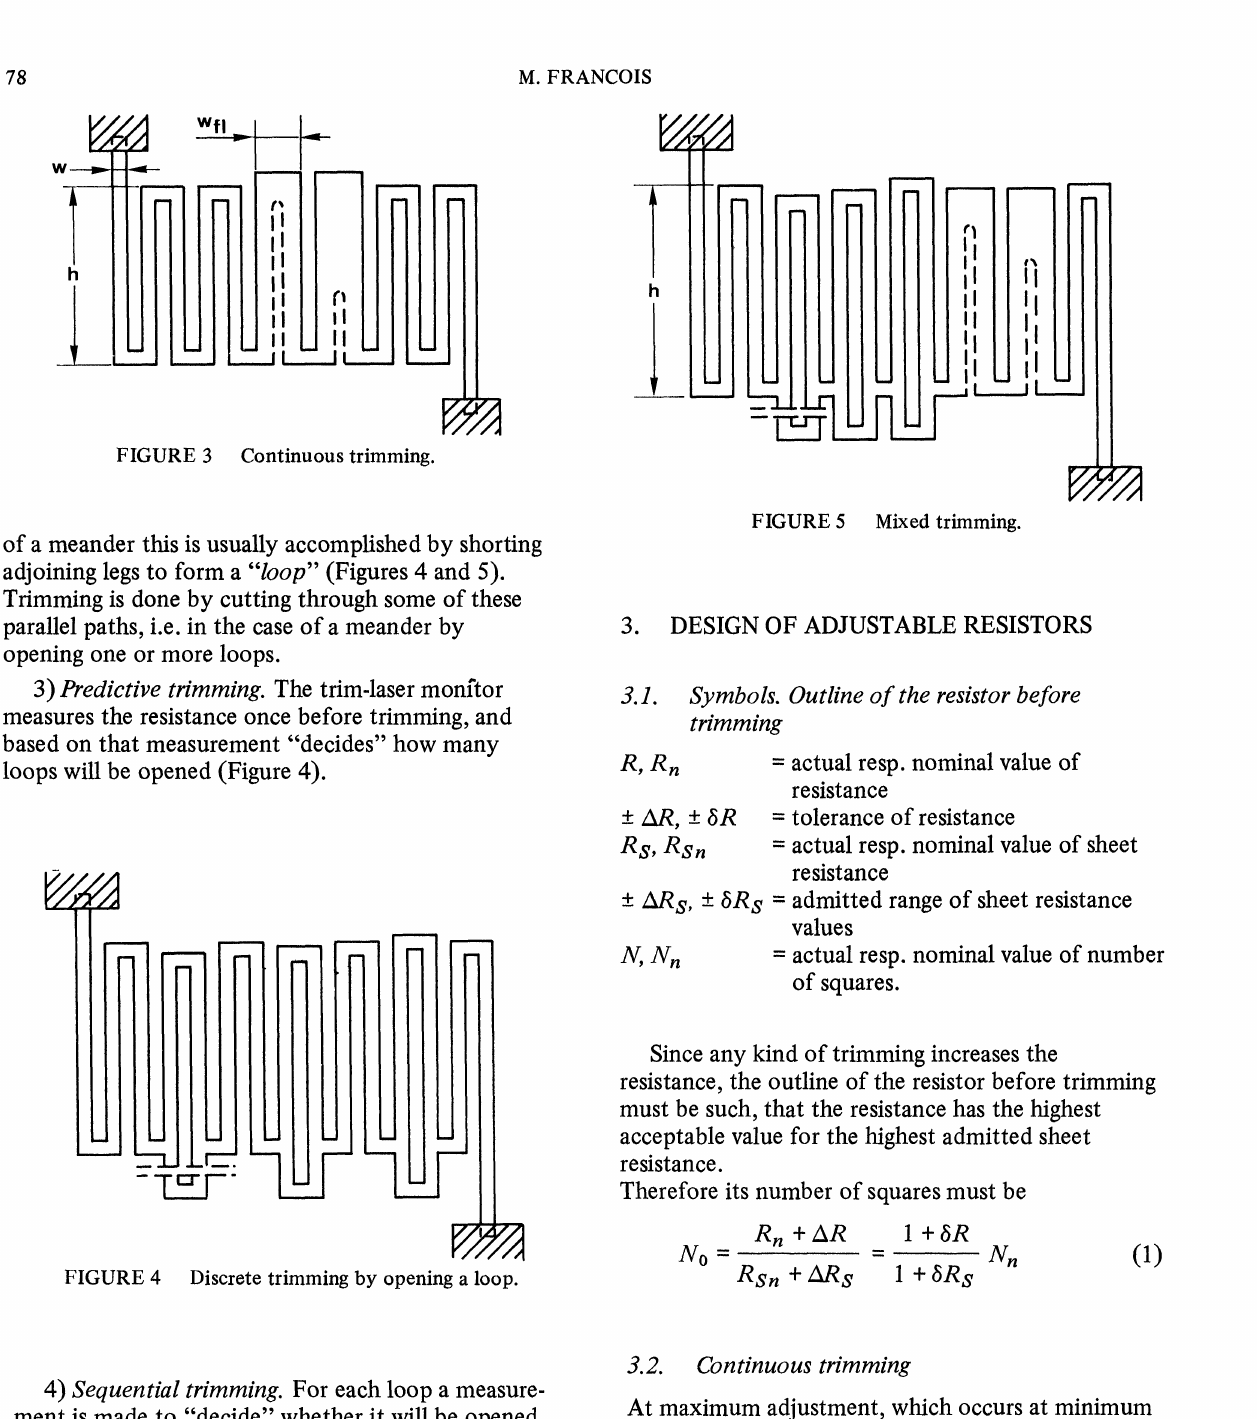
FIGURE 4 Discrete trimming by opening a